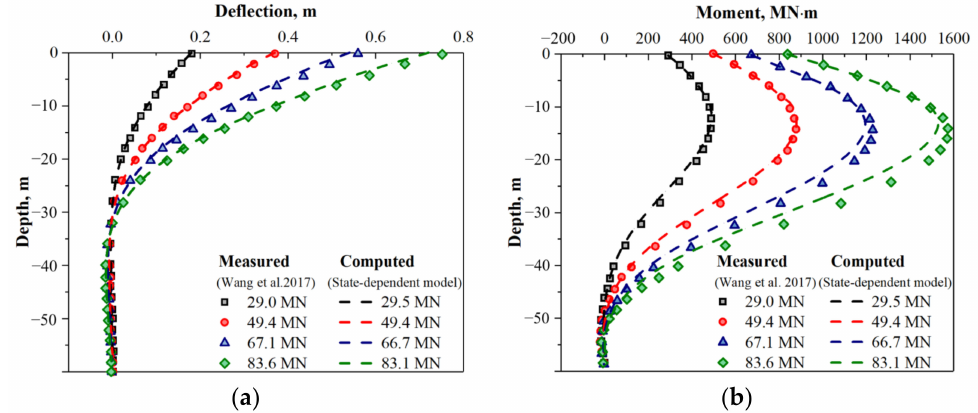
Figure 2. Validation of the numerical model against the centrifuge test reported by Wang et al. [25], compared with ( a ) deflection; ( b ) moment of the